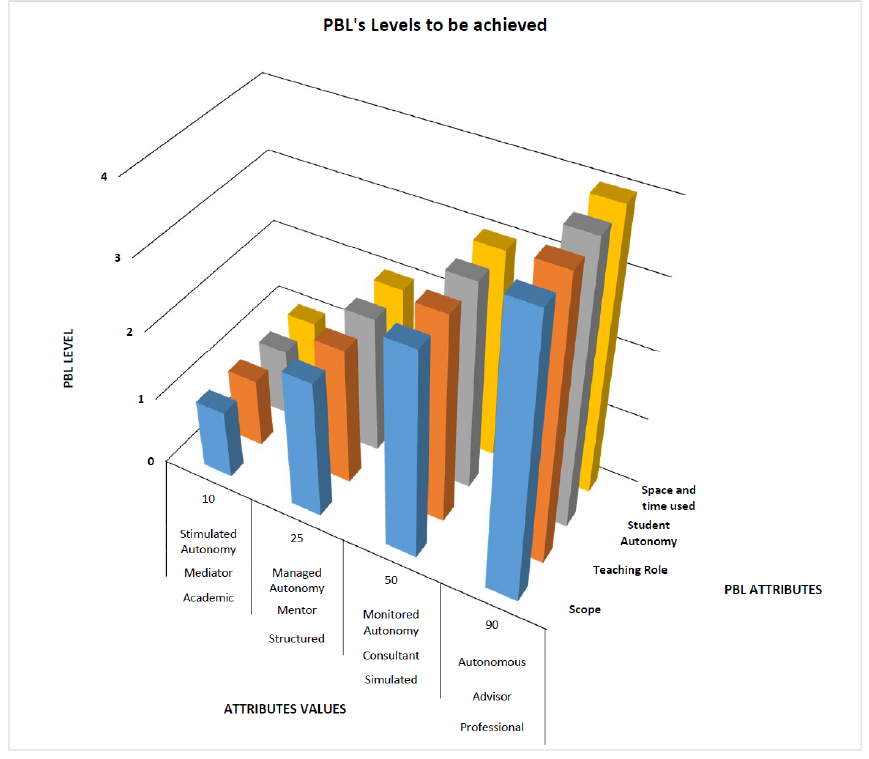
Fig. 1. PBL’S level of